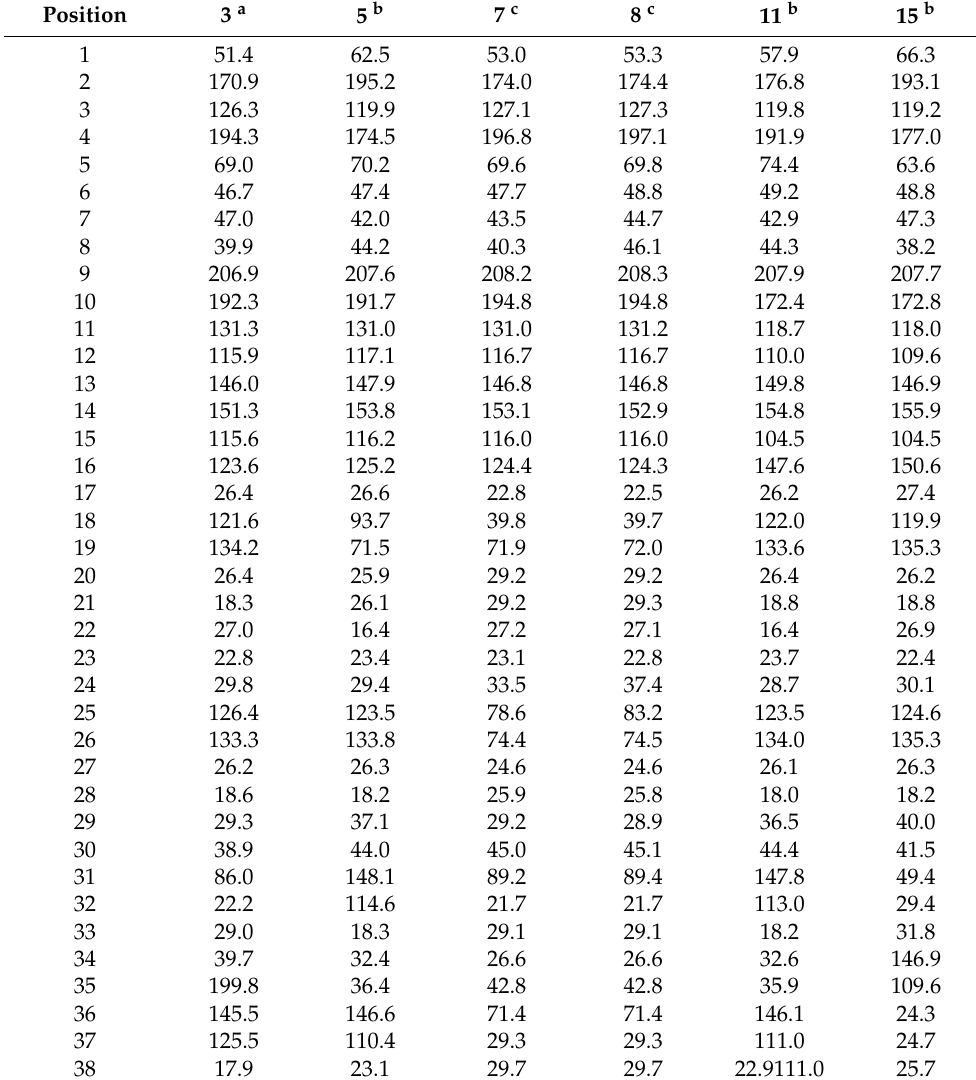
Table 2. 13 C NMR (125 MHz) data of compounds 3 , 5 , 7 – 8 , 11 , and 15